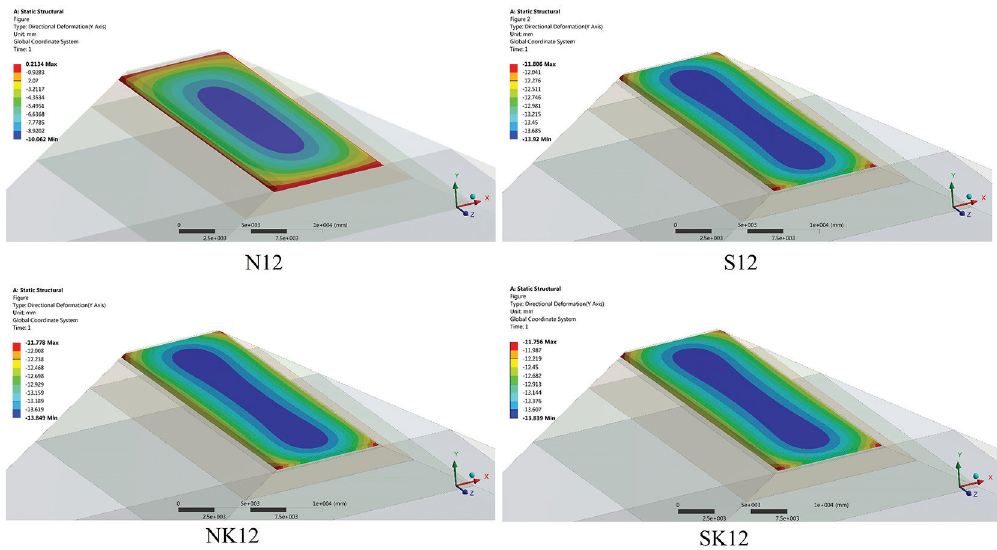
Figure 9. Vertical deformations on FEM models for the first